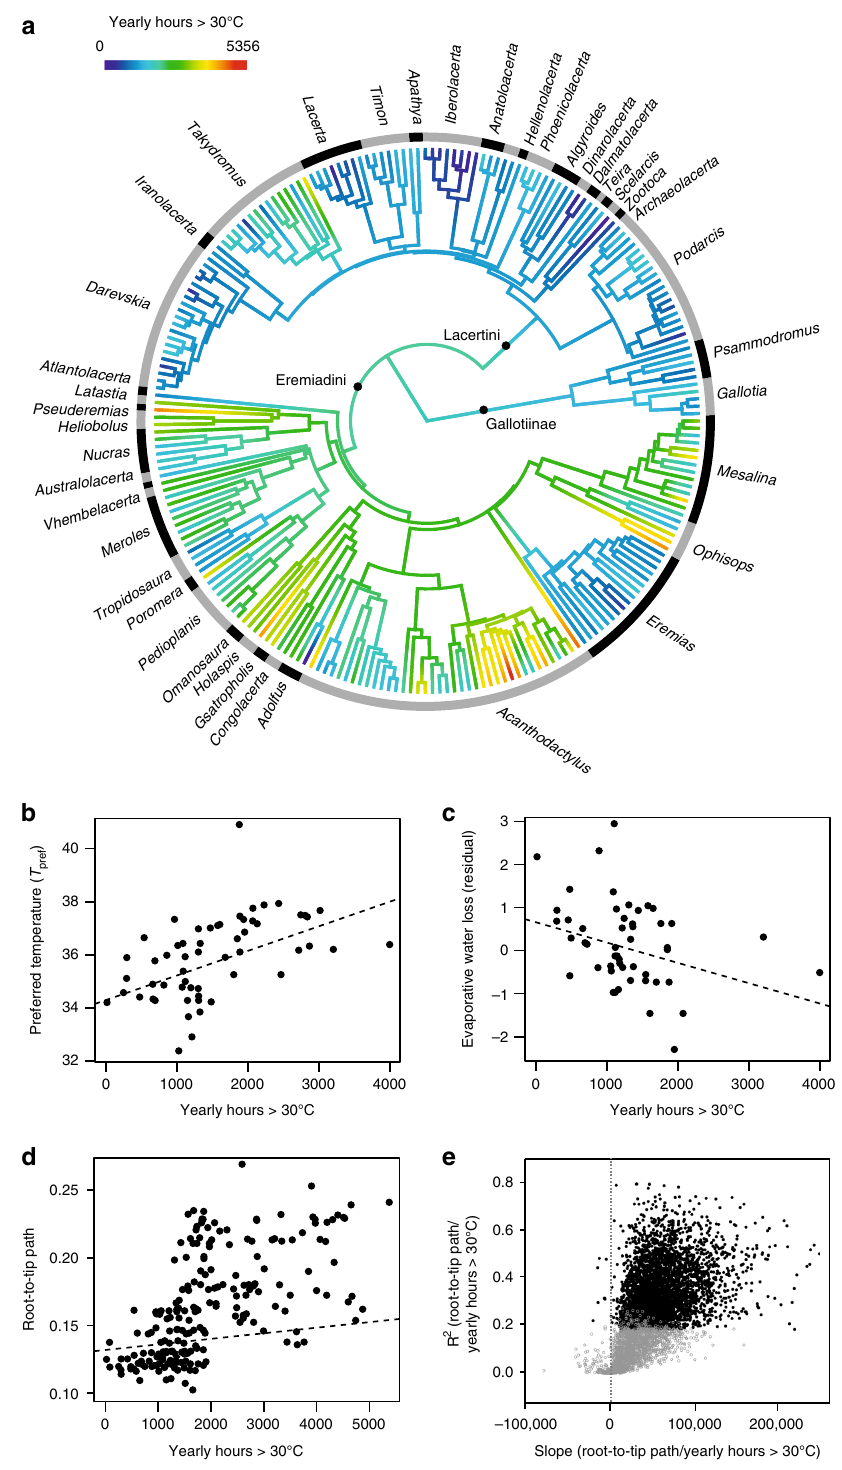
Fig. 2 Associations between environmental temperature, physiology, and molecular substitution rates of lacertids. a Time-calibrated phylogeny derived from partitioned ML analysis of the combined dataset for 262 lacertid species. Colors represent character state reconstruction for yearly hours >30 °C of the species ’ ranges computed from an occurrence record database. b – d Scatterplots among T pref and IWL, and root-to-tip path (a proxy for molecular substitution rate) against a bioclimatic variable (yearly hours >30 °C) derived from distribution range information (all phylogenetic regressions signi fi cant; fi tted regression lines calculated using a phylogenetic linear model, see main text and test statistics in Supplementary Information). e Plot of R 2 vs. slope clues for regressions of root-to-tip paths vs. environmental temperature for 5878 gene trees derived from the RNAseq analysis, showing a positive slope for the majority of genes. Black dots are statistically signi fi cant correlations at P < 0.05. Source data are provided as a Source Data fi